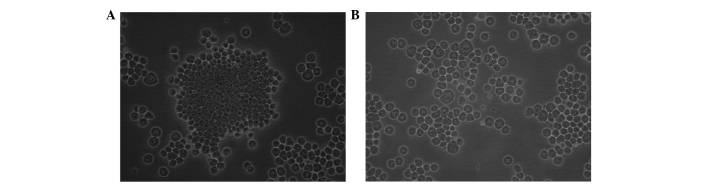
(A) Cells prior to treatment with H2O2. (B) Cells treated with 200 μmol/l H2O2 for 15 min. Magnification, ×200.